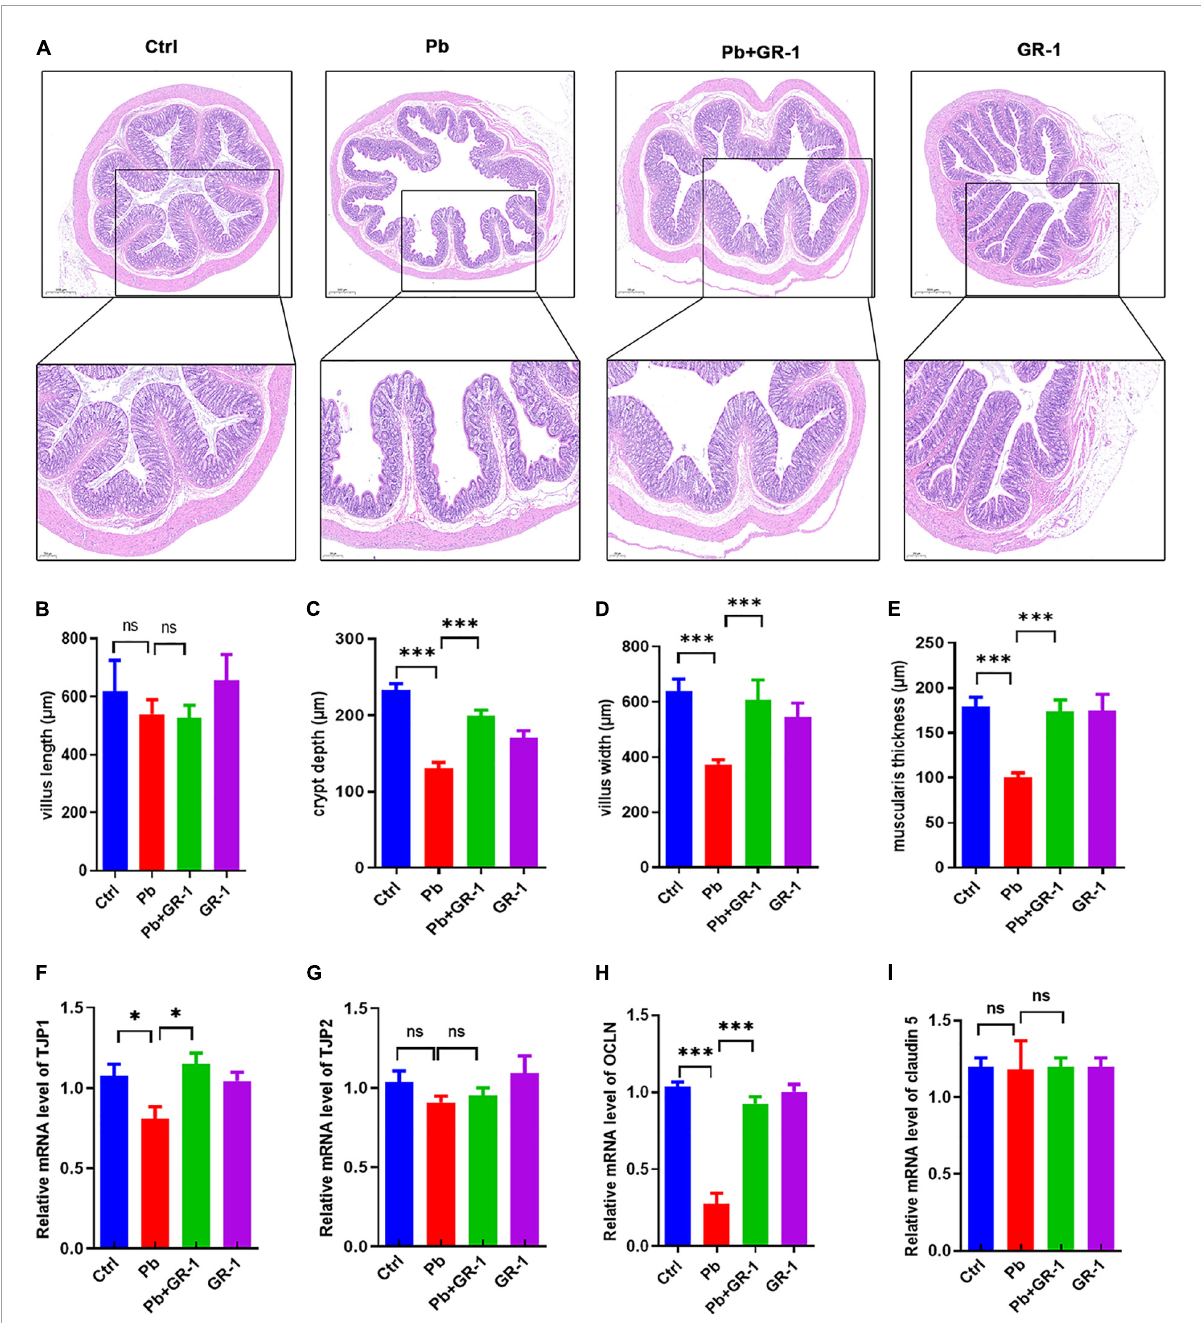
FIGURE5 Lactobacillus rhamnosus GR-1 treatment alleviated intestinal damage of Pb-exposure rats. (A) The representative H&E staining images of colon tissue sections. n = 3. (B–E) The villus, crypt depth, villus width, and muscularis thickness of the colon in Ctrl, Pb, Pb + GR-1, and GR-1 groups. n = 3. (F–I) The mRNA levels of tight junction proteins in Ctrl, Pb, Pb + GR-1, and GR-1 groups, including TJP1, TJP2, OCLN, and claudin 5. n = 3 Data are shown as mean ± SEM. ∗ p < 0.05, ∗∗∗ p < 0.001.